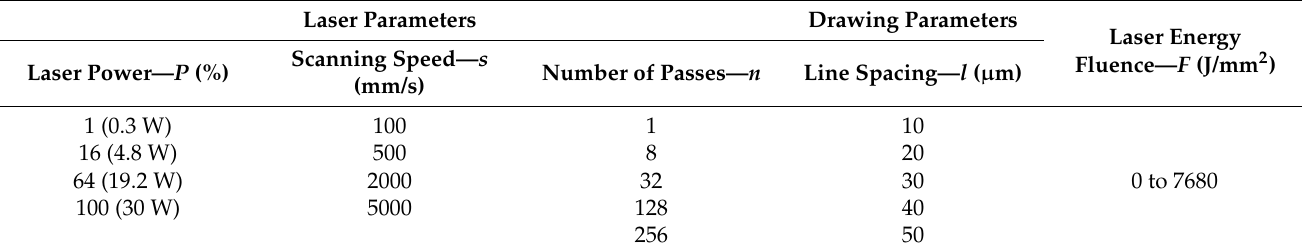
Figure 1. Texturing process: laser strategy with a different number of lines and line spacings. Table 1. Summary of the processing parameters used for the laser machining of the 420 stainless steel surface.